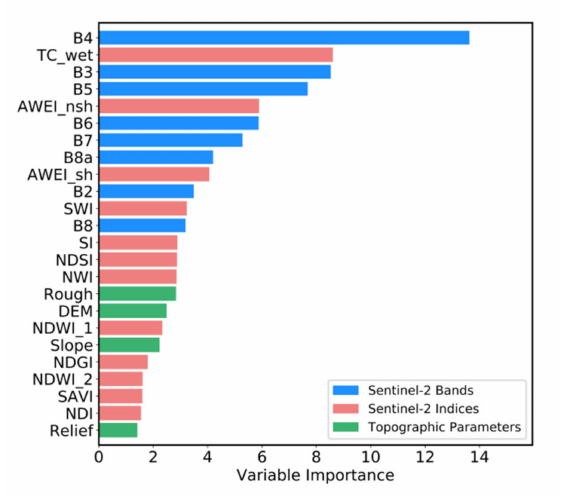
Figure 5. Feature importances for the Random Forest (RF) training variables averaged over all training regions and